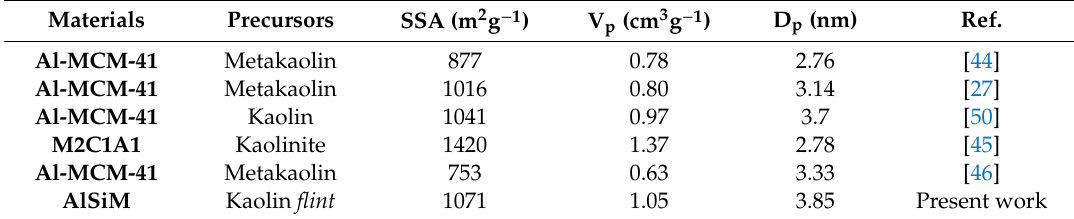
Table 3. Synthesis of mesoporous aluminosilicate from kaolinite precursors.